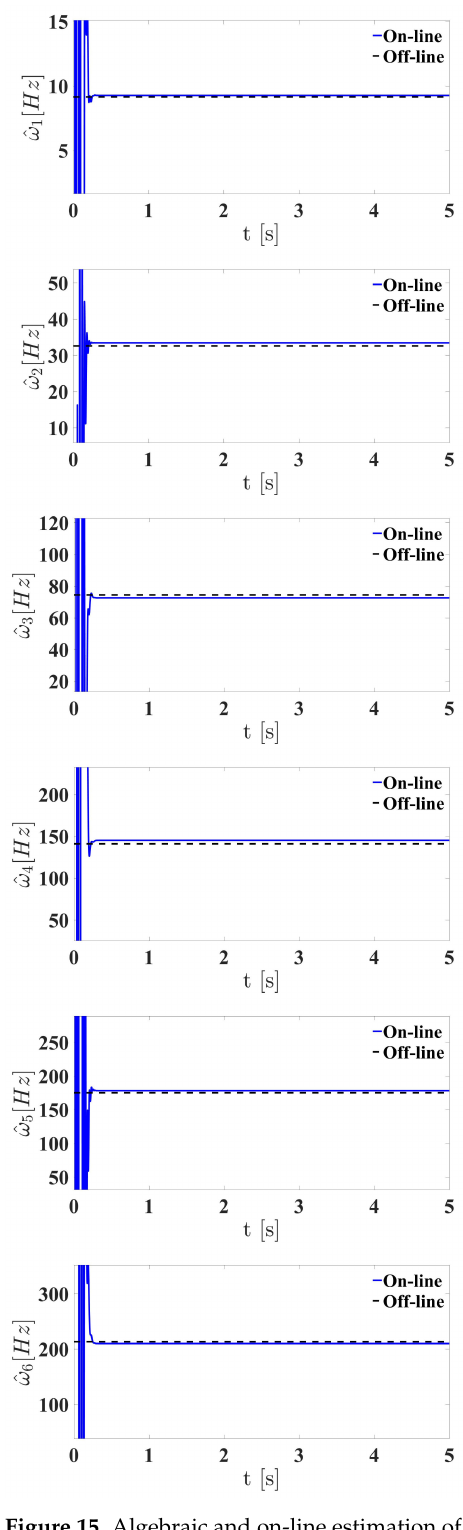
Figure 15. Algebraic and on-line estimation of natural